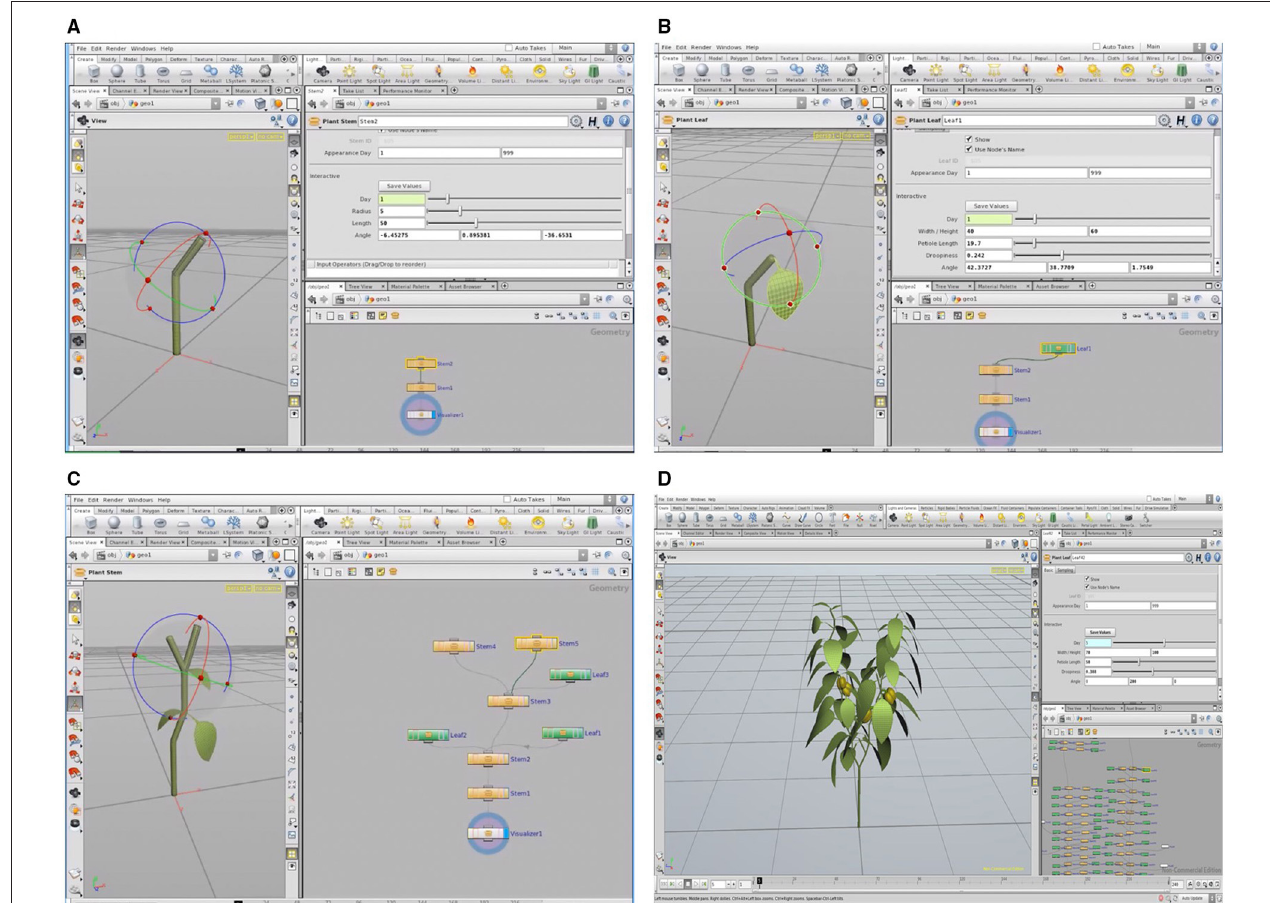
FIGURE 3 | A 3D virtual plant constructed in the L-system using the Houdini FX graphic software: construction of paprika stem (A) and leaf (B), the process of modeling the paprika (C), and tree window of L-system formalism and graphic window of the completed paprika structure